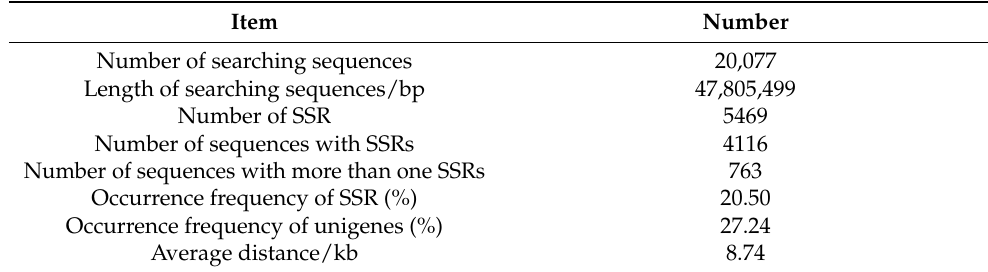
Table 1. SSR search result in M. azedarach transcriptome.